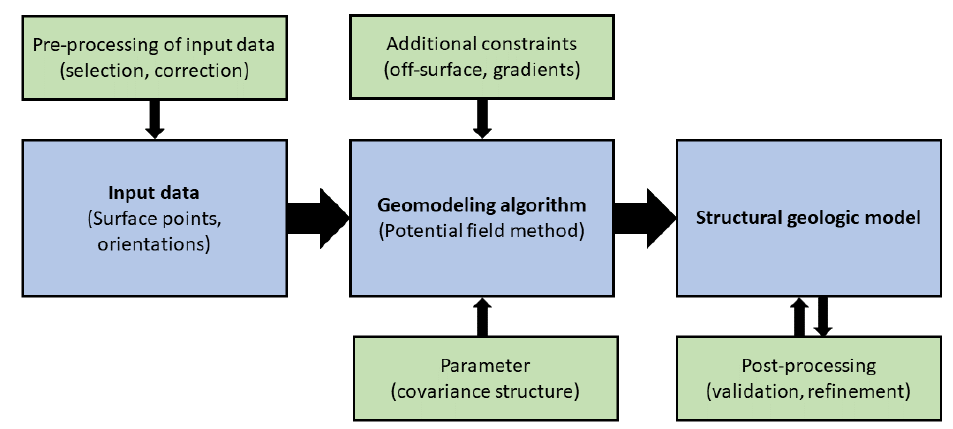
Figure 1. Typical geomodeling workflow using the potential field method (blue) and measures taken to improve models at different steps of the workflow